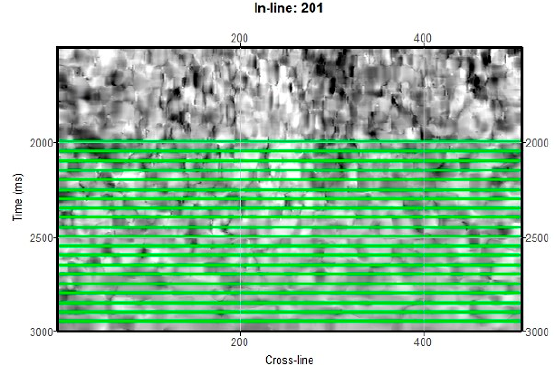
Figure 3. Location distribution of seismic attribute slice. Below 3050 m (1800 ms) underground, we obtain 21 time slices from 2000 ms to 3000 ms at intervals of 100 ms.